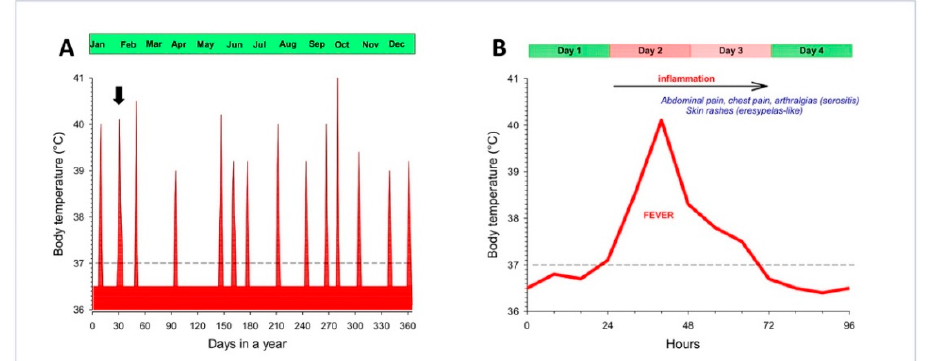
Figure 3. Schematic appearance of time-dependent changes of body temperature in Familial Mediterranean Fever (FMF) before starting the treatment with colchicine. The profile refers to a typical case belonging to a cluster of families identified in the region of Apulia, Italy [24] . ( A ) Frequency of febrile attacks in a year. The dotted horizontal line is placed at 37 °C (cut-off value). In between attacks, the temperature has been conventionally set at 36.5 °C. This patient reported a total of 14 attacks in a year. The black arrow indicates the febrile attack described in panel B. ( B ) The single febrile attack lasts about 48 h and is associated with a major auto-inflammatory status and symptoms. Adapted from Portincasa et al. Familial Mediterranean fever: a fascinating model of inherited auto inflammatory disorder. Eur J Clin Invest 43, 1314-1327 (2013) with permission from John Wiley & Sons Ltd. [24] .